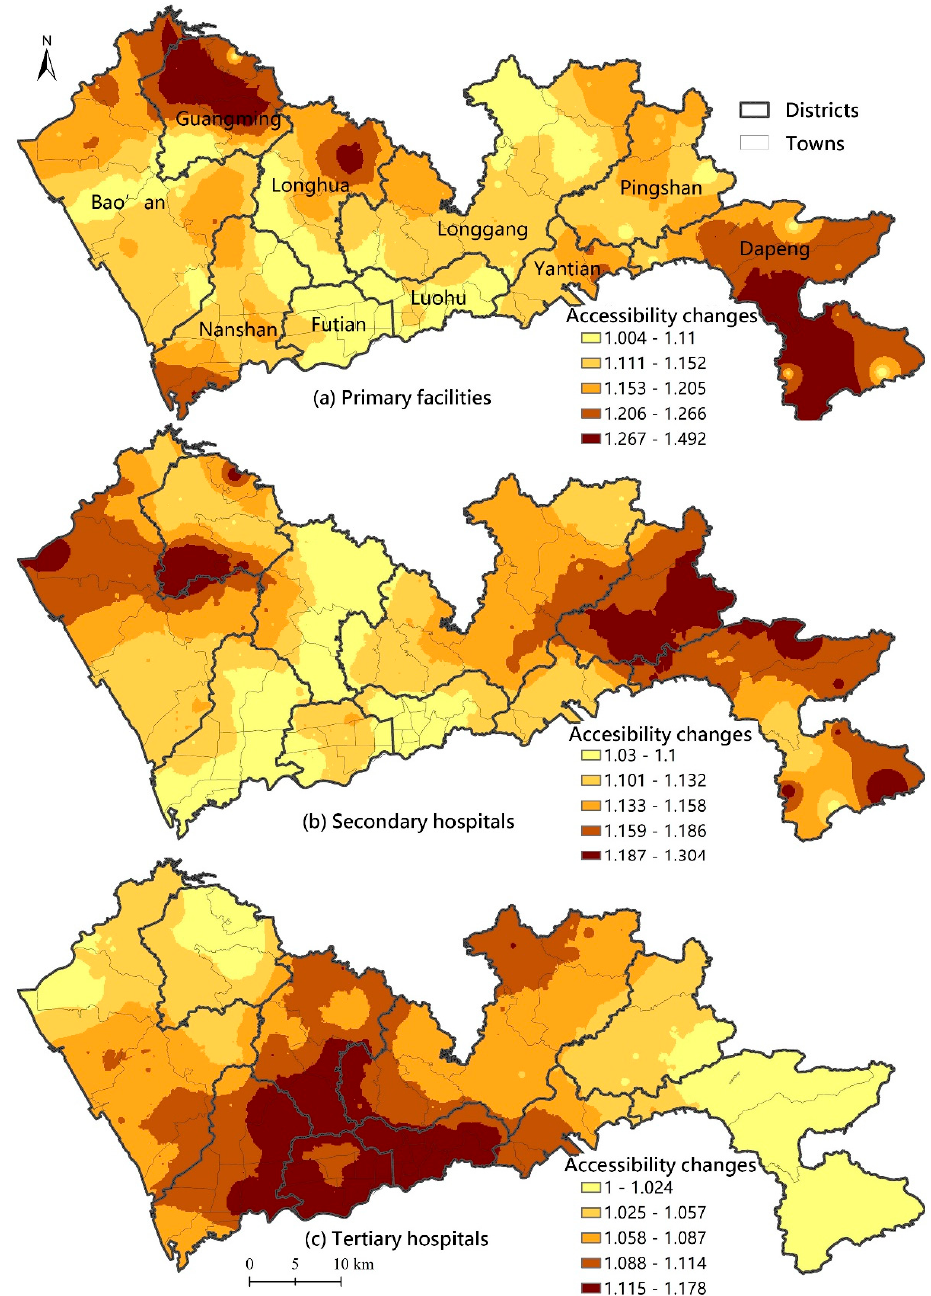
Figure 7. The distribution of accessibility impacts by adding supply at different levels in Shenzhen.